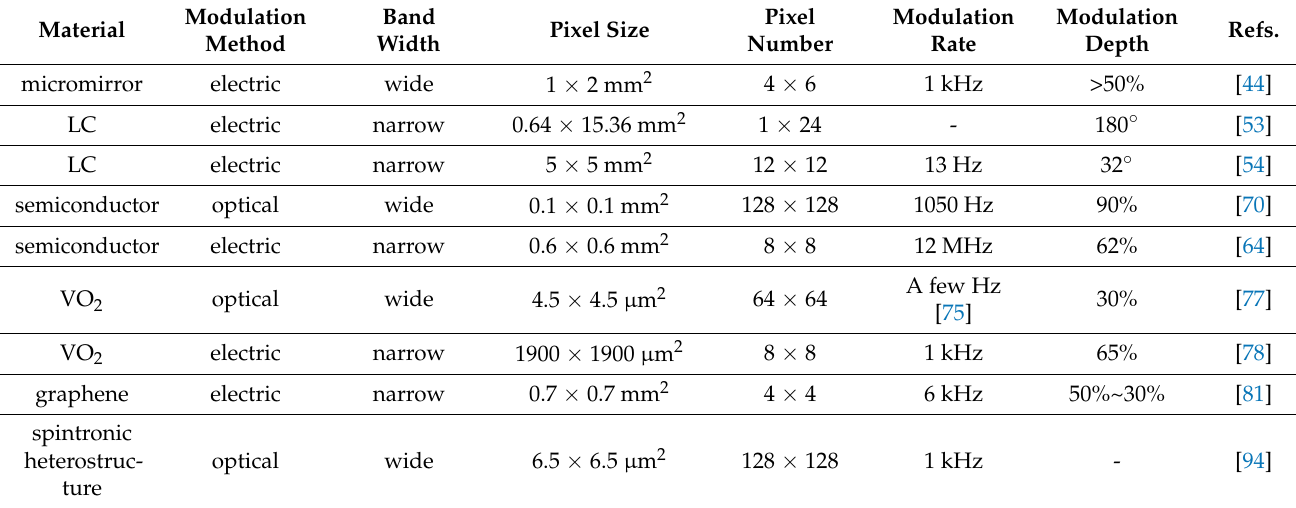
Table 1. Comparison of the specifications of the representative THz